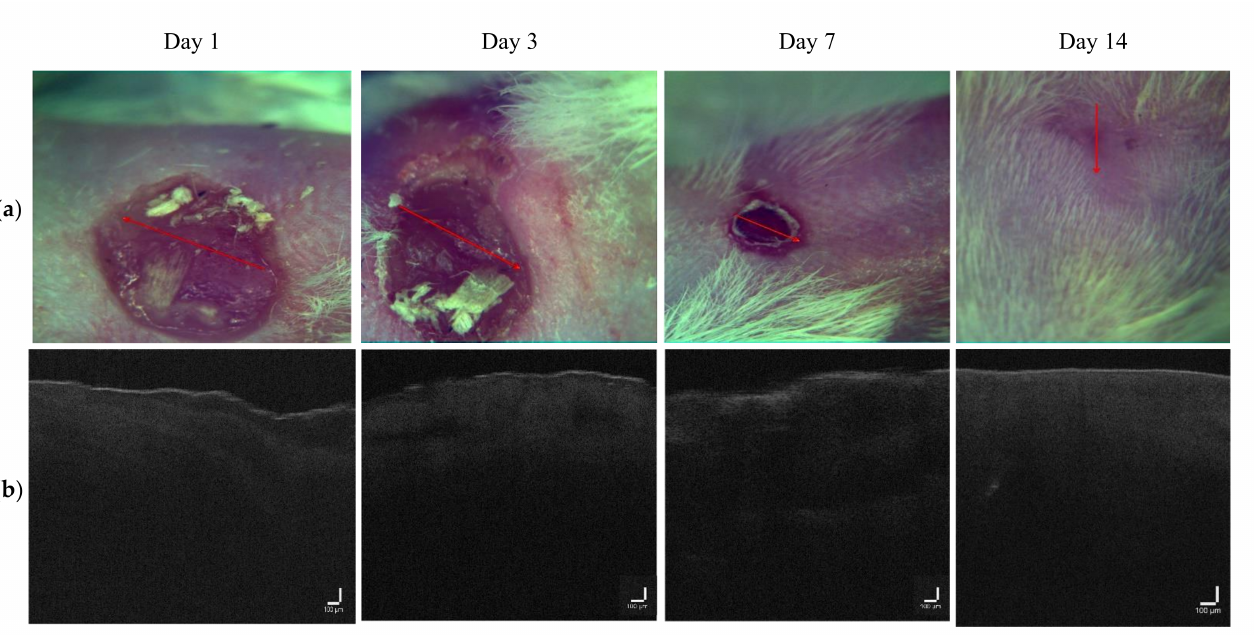
Figure 10. ( a ) Visual observation and ( b ) the corresponding B-scans for the LDPDT-MB 1 J/cm 2